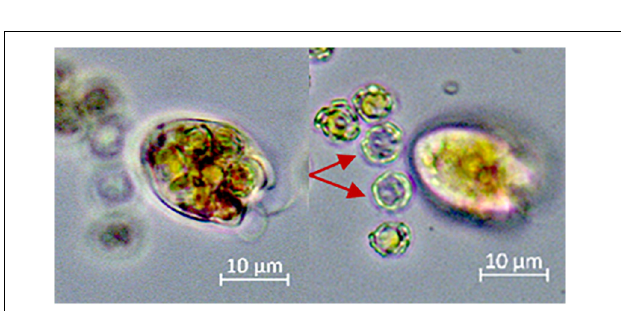
FIGURE 7 | The figure shows two images taken from the same cell of O. marina in different focal planes. The predator was packed with several E. huxleyi and egested visually empty coccospheres (red arrows) within a few